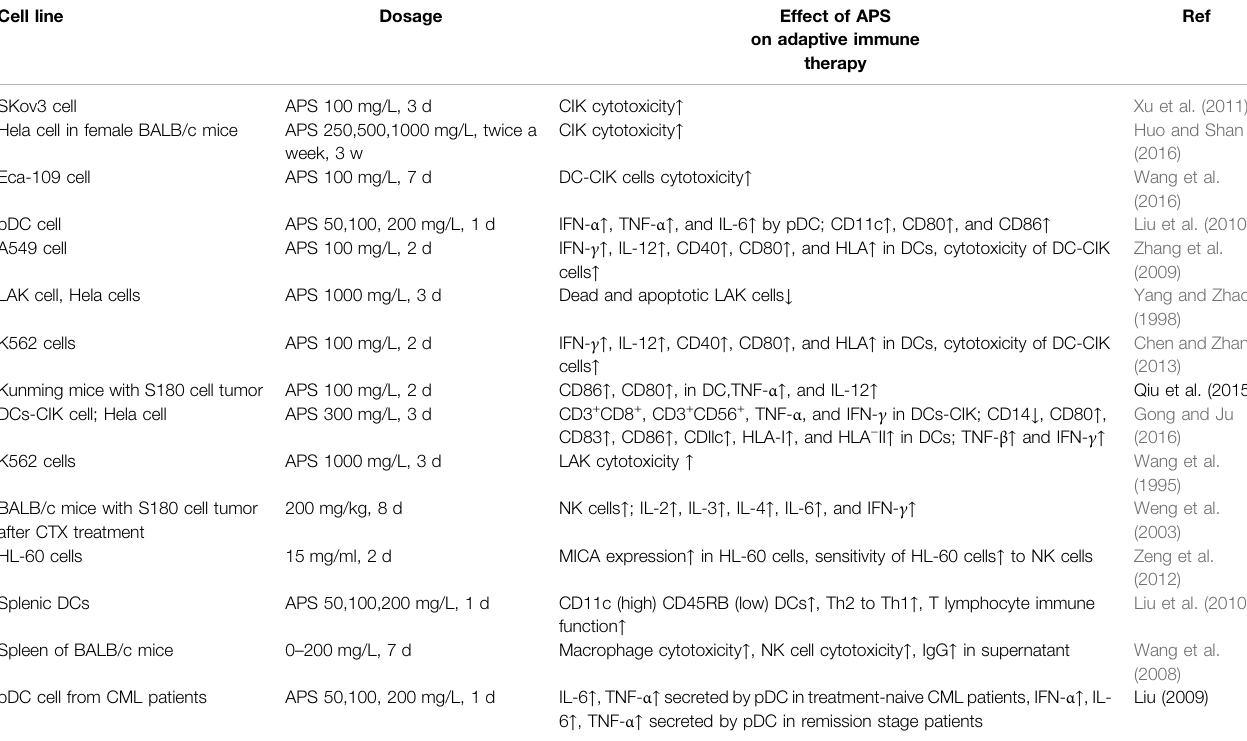
TABLE 1 | Effect of APS on adaptive immune